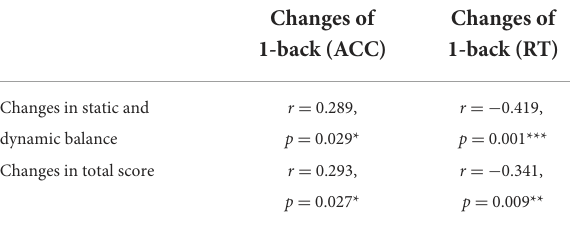
TABLE 6 Correlations between motor performance and working memory changes.